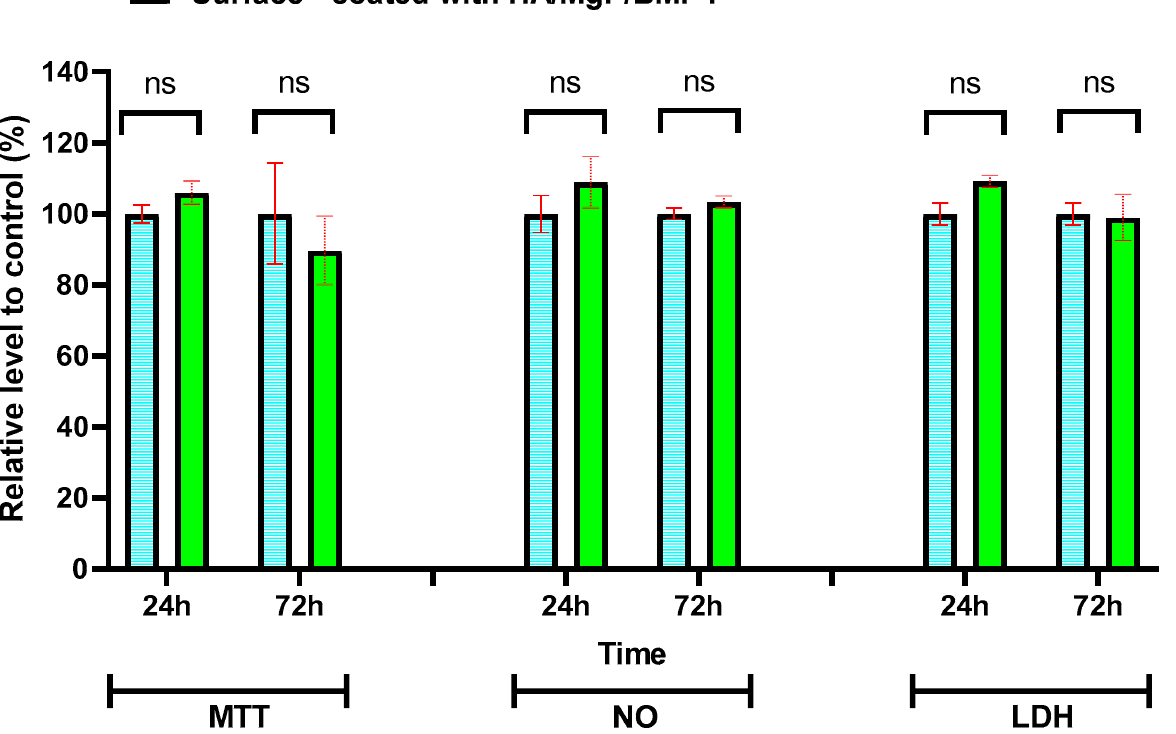
Figure 7. Cellular viability, NO level, and LDH release after 24 h and 72 h of MC3T3-E1 osteoblasts’ growth on the control surface and in contact with HA/MgP/BMP4 coating; ns = not significant, p > 0.05. The lack of cytotoxicity towards the MC3T3-E1 cells was also confirmed by the levels of NO and LDH release, which were comparable with those obtained for the control sample after both intervals of incubation, 24 h and 72 h. No significant inflammation and damage on the cell membrane ( p > 0.05) were noticed during the 72 h incubation of cells on the tested coating. Thus, the in vitro results showed that this HA/MgP/BMP4 coating